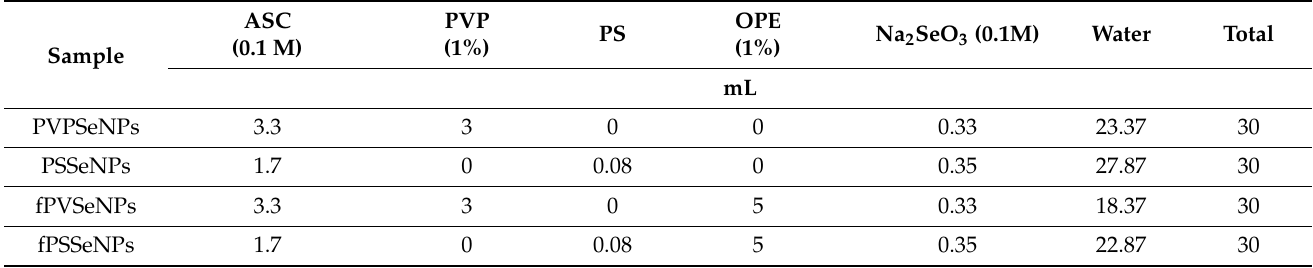
Table 3. Composition of reaction mixtures used for synthesis of